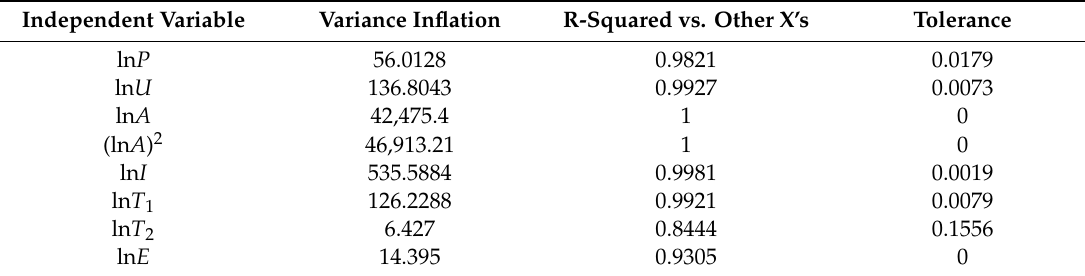
Table 3. Least squares